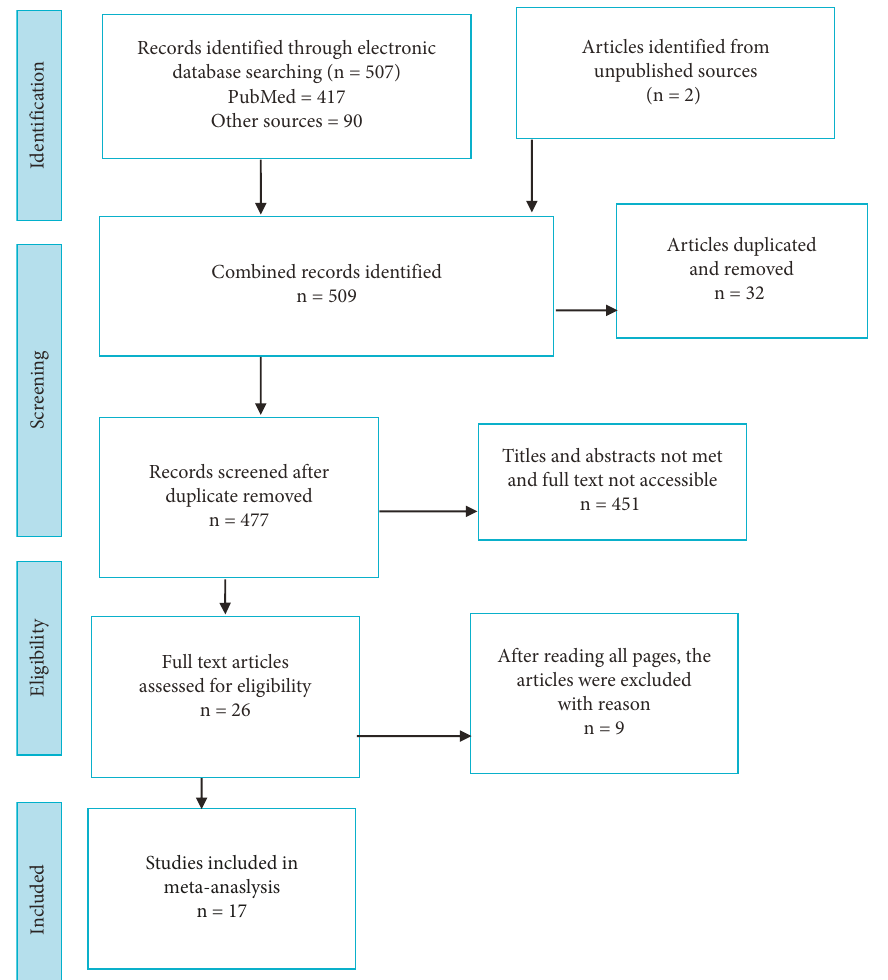
Figure 1: PRISMA flow chart revealing study selection for systematic review and meta-analysis of ACFP among mothers who had IYC in